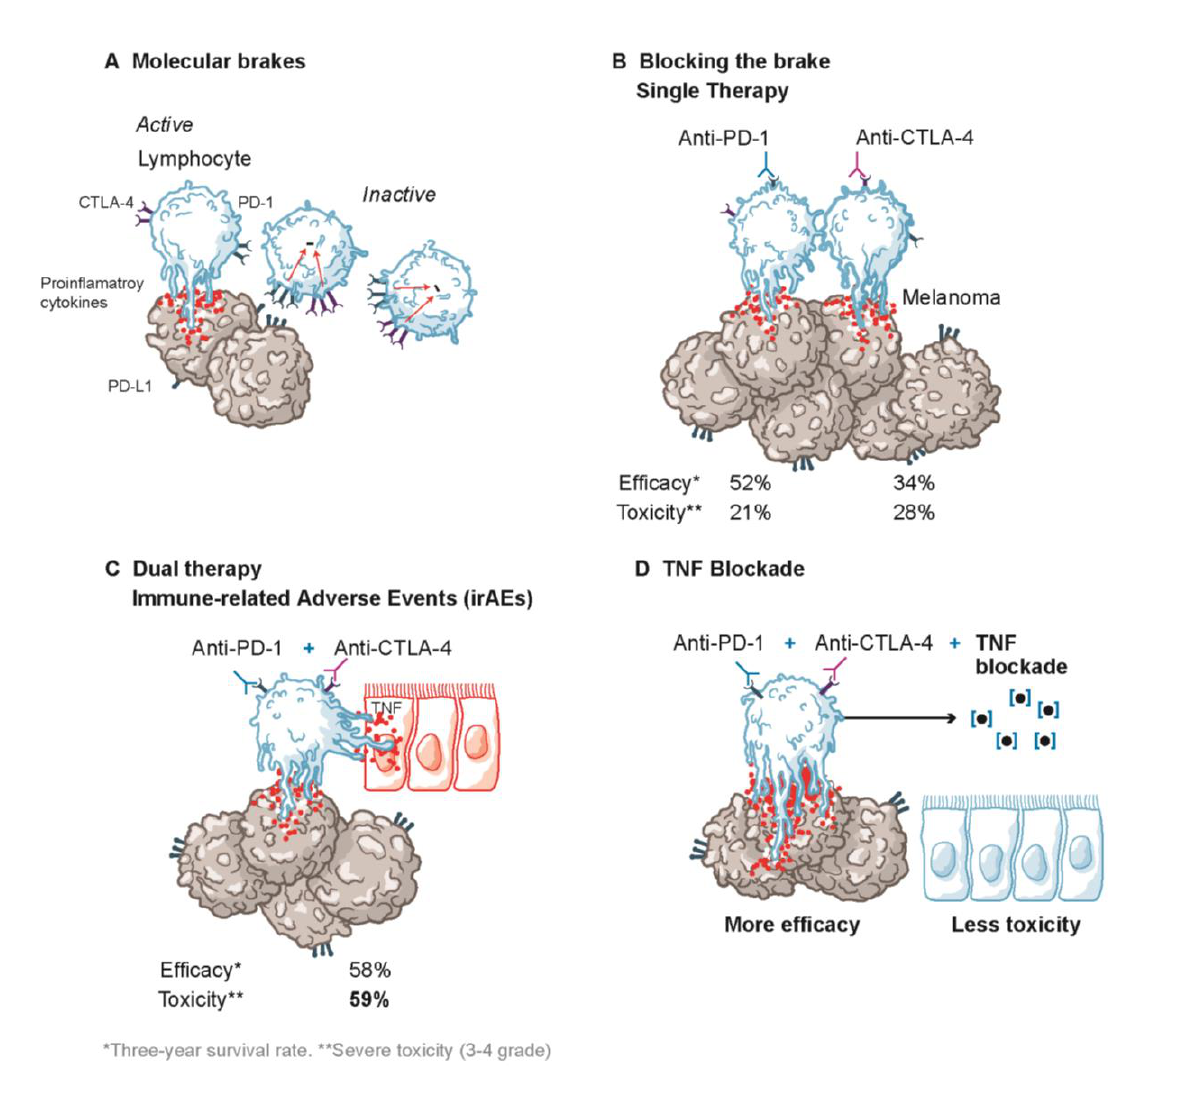
FIGURE 1: Reducing the toxicity of cancer immunotherapy . (A) The presence on activated lymphocytes of the inhibitory receptors PD-1, which binds to PD-L1, and CTLA-4, which binds to the costimulatory molecules CD80 and CD86, causes immune cell dysfunction facilitat- ing tumor evasion. (B) The introduction of inhibitory blockade therapy that prevents PD-1/PD-L1 or CTLA-4/CD86-CD80 interactions by monoclonal antibody therapy has shown to improve CD8 T cell cytotoxic function and thus has been successfully implemented in a varie- ty of tumors such as melanoma, with little toxicity. (C) Dual therapy that combines anti-PD-1 and anti-CTLA-4 has a more effective anti- tumor response when compared to single therapy, but, at the cost of the increase in the frequency of immune-related adverse events, which induces tissue damage, being TNF an important mediator of this effect. (D) The administration of dual ICB therapy in combination with prophylactic TNF neutralization is able to palliate the treatment-related toxicity side effects while becoming more efficacious to- wards the anti-tumor response by limiting the activation induced cell death (AICD) on the OPEN ACCESS | www.cell-stress.com